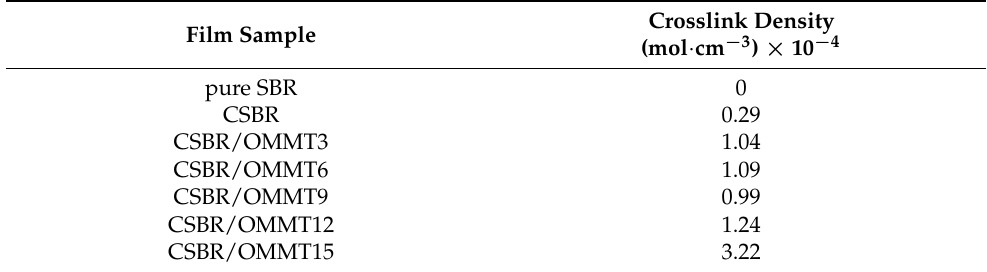
Table 6. The values of the crosslinking densities of pure SBR, CSBR and CSBR/OMMT nanocomposites. Film